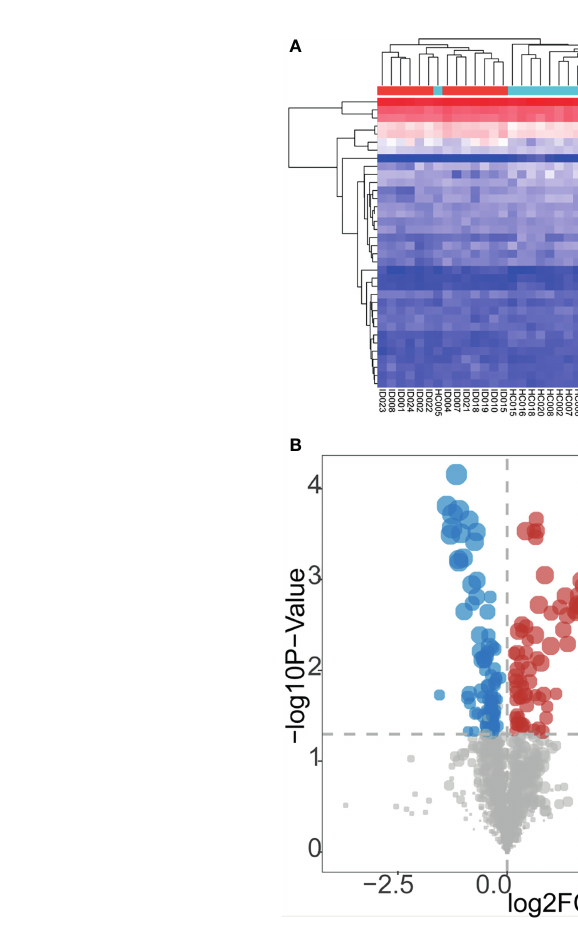
FIGURE 2 | Patients with insomnia showed differential serum metabolic pro fi les compared with healthy controls. (A) A heatmap of metabolites with signi fi cantly altered concentrations between insomnia and healthy control groups. Red and blue represent increased and decreased metabolites, respectively, in patients with insomnia compared with those in healthy controls. (B) A dot plot of metabolites in the serum samples of the participants. Blue and red dots represent signi fi cantly decreased and increased metabolites in the serum samples of insomnia patients compared with those of healthy controls. Gray dots represent nonsigni fi cantly changed